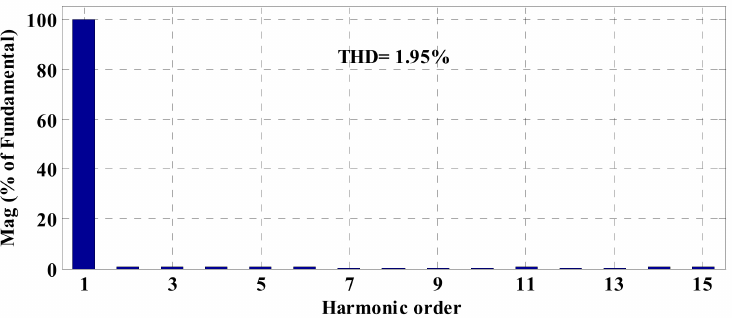
Figure 7. THD spectra of load-side voltage of DG1 based on the conventional control method.